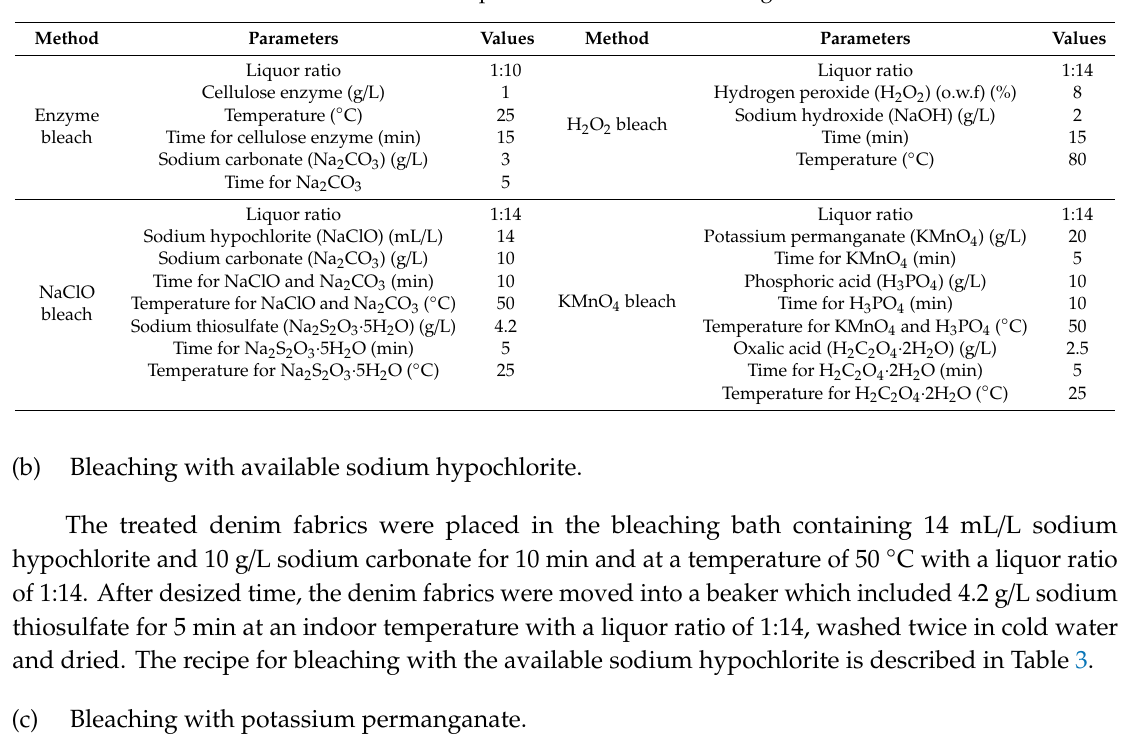
Table 3. Recipe for conventional